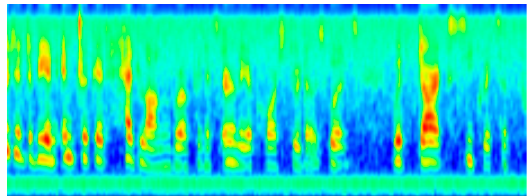
Figure 2. Cochleogram.